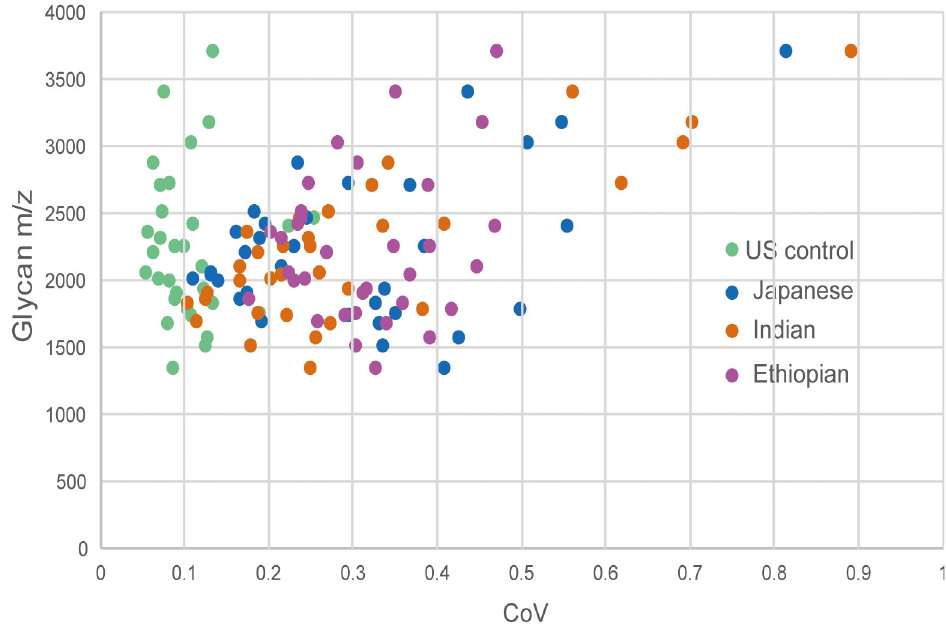
Fig 6. CoV illustrating the inter-subject extent of variation within each ethnic group. Y-axis shows m/z values of detected N -glycans, X-axis shows the coefficient of variation (CoV) value representing how far the glycan concentration was scattered within subjects of each ethnic